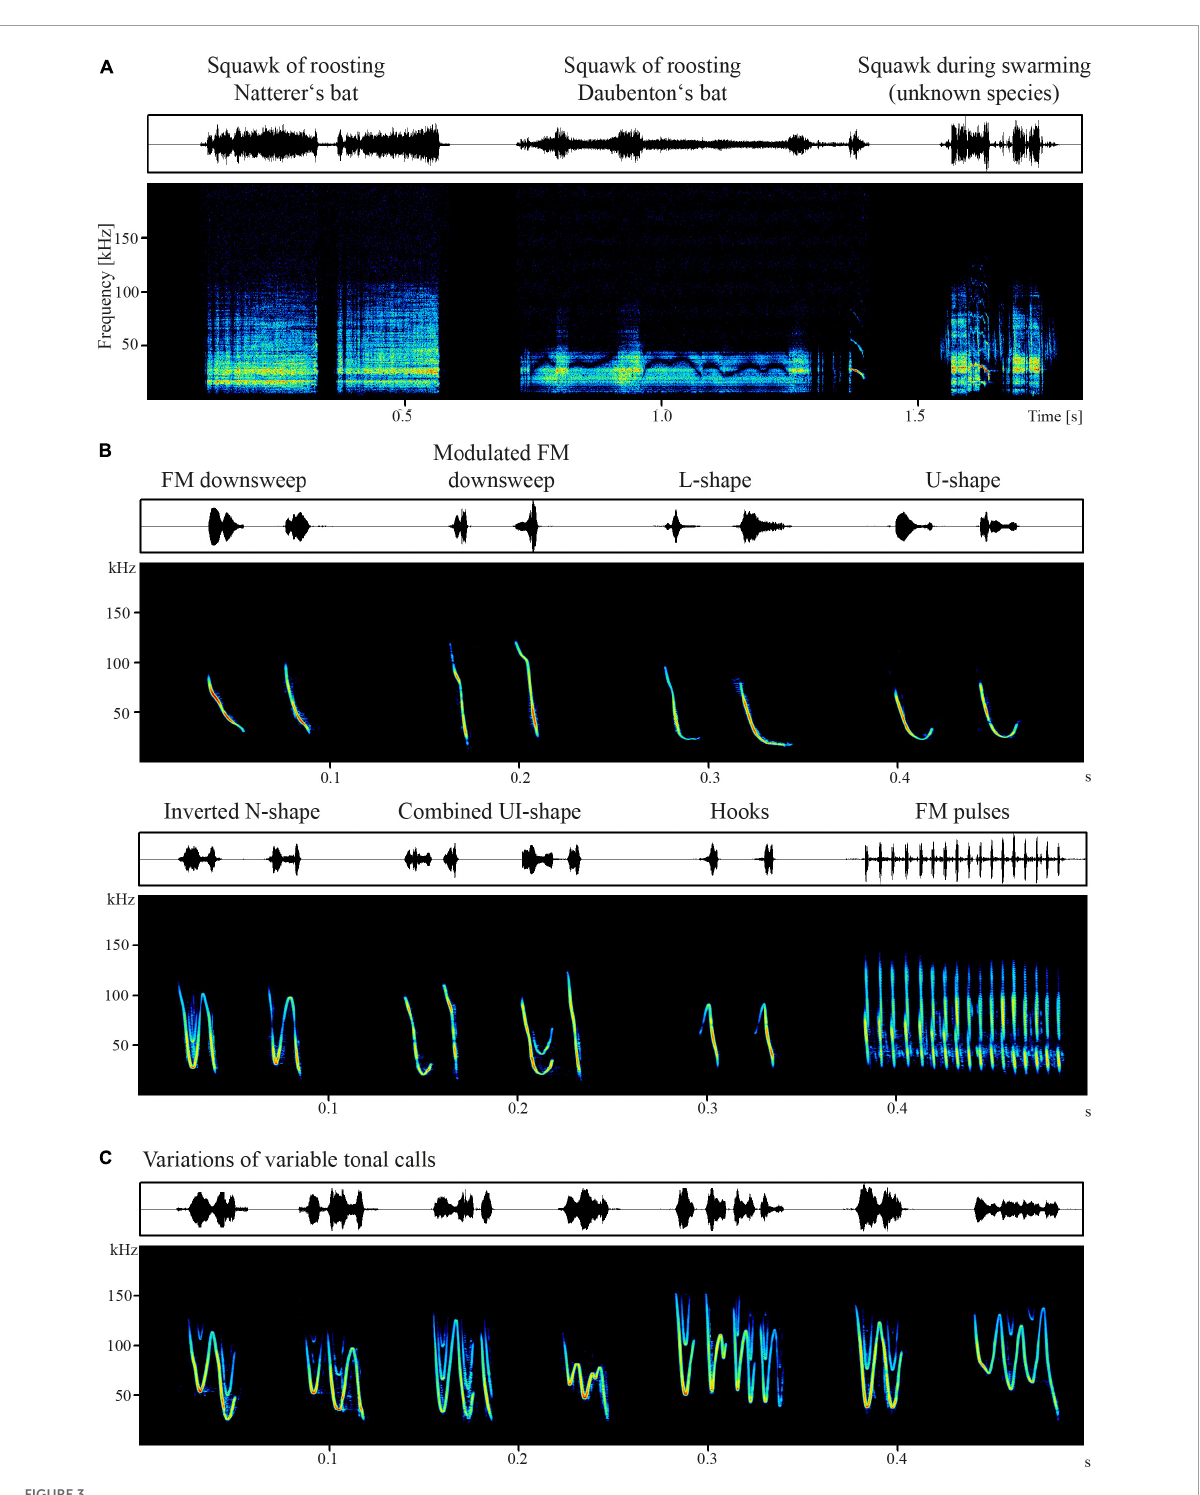
FIGURE3 Spectrograms of all call types we found during autumn swarming. The calls were grouped based on their spectro-temporal structure and confirmed through a discriminant function analysis with temporal and spectral parameters. (A) Squawks recorded at the Spandau Citadel from identified bats in crevices (left and middle) and from an unidentified bat during autumn swarming at the Kalkberg cave (right). (B) Short tonal calls emitted singly or in sequence. (C) Variable tonal calls grouped into one group, usually longer than other tonal calls and often emitted in sequence. Spectrograms were created using Avisoft SASLabPro with a Hamming window, 100% frame size and an overlap of 87.5% (B,C) or 50% (A)